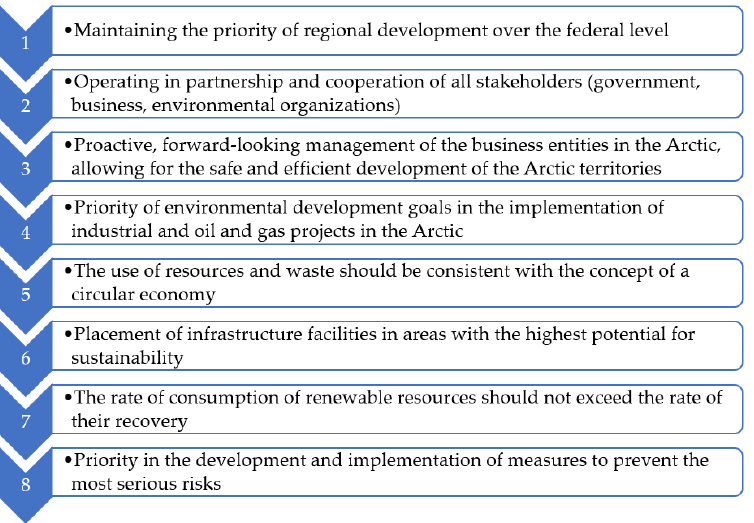
Figure 4. Environmental risk map.